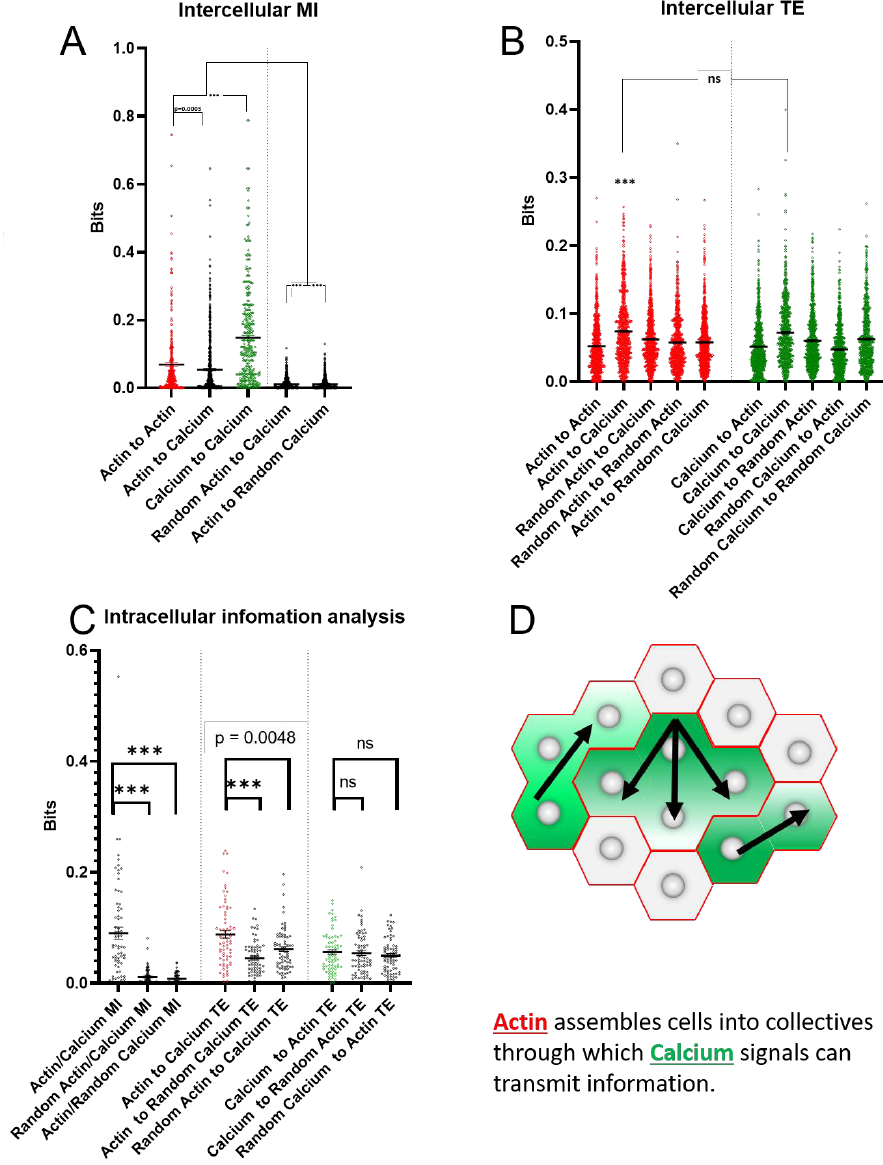
Figure 10. Information metrics between the calcium and actin signals. MI between the actin signal of nearby ROIs, between the calcium signal of nearby ROI, and between actin and calcium signal of nearby ROIs is significantly higher than MI between the randomized actin signal and calcium or the randomized calcium signal to actin. ( A ) The highest MI is observed between nearby ROIs within the calcium signal, with MI between nearby ROIs for the actin signal being significantly higher than MI between the two signals; ( B ) within nearby ROIs, both the actin and calcium signals have significant TE to the calcium signal as compared with randomized controls, with the actin and calcium TE to calcium being statistically insignificant, neither has significant TE to the actin signal; ( C ) within a single ROI, the actin and calcium signals have significant MI, but while the calcium has significant TE to calcium the reverse is not true. From these data we propose a model in which actin establishes boundaries through which calcium signals flow ( D ). *** = p > 0.0001, Mann–Whitney